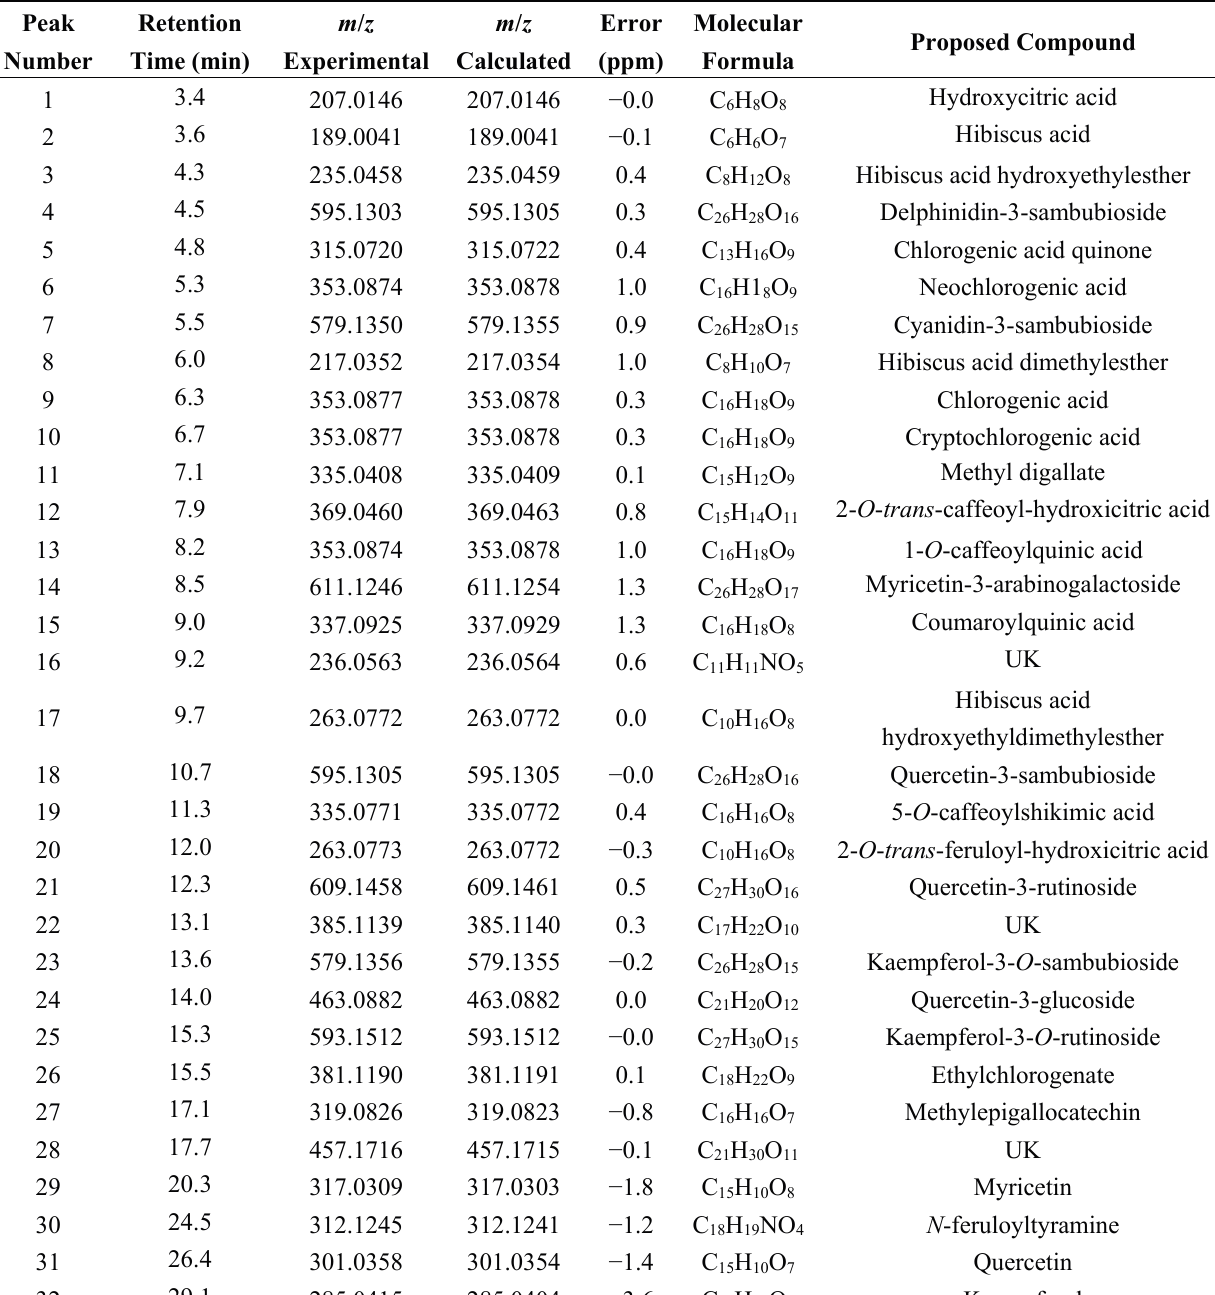
Table 1. List of the compounds detected in phenolic-enriched Hibiscus sabdariffa (PEHS) extract with the main details about mass-spectra